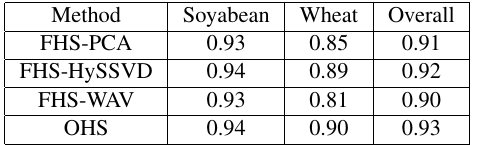
Table 5: Class wise Rank Correlation values for different meth- ods on pure pixels